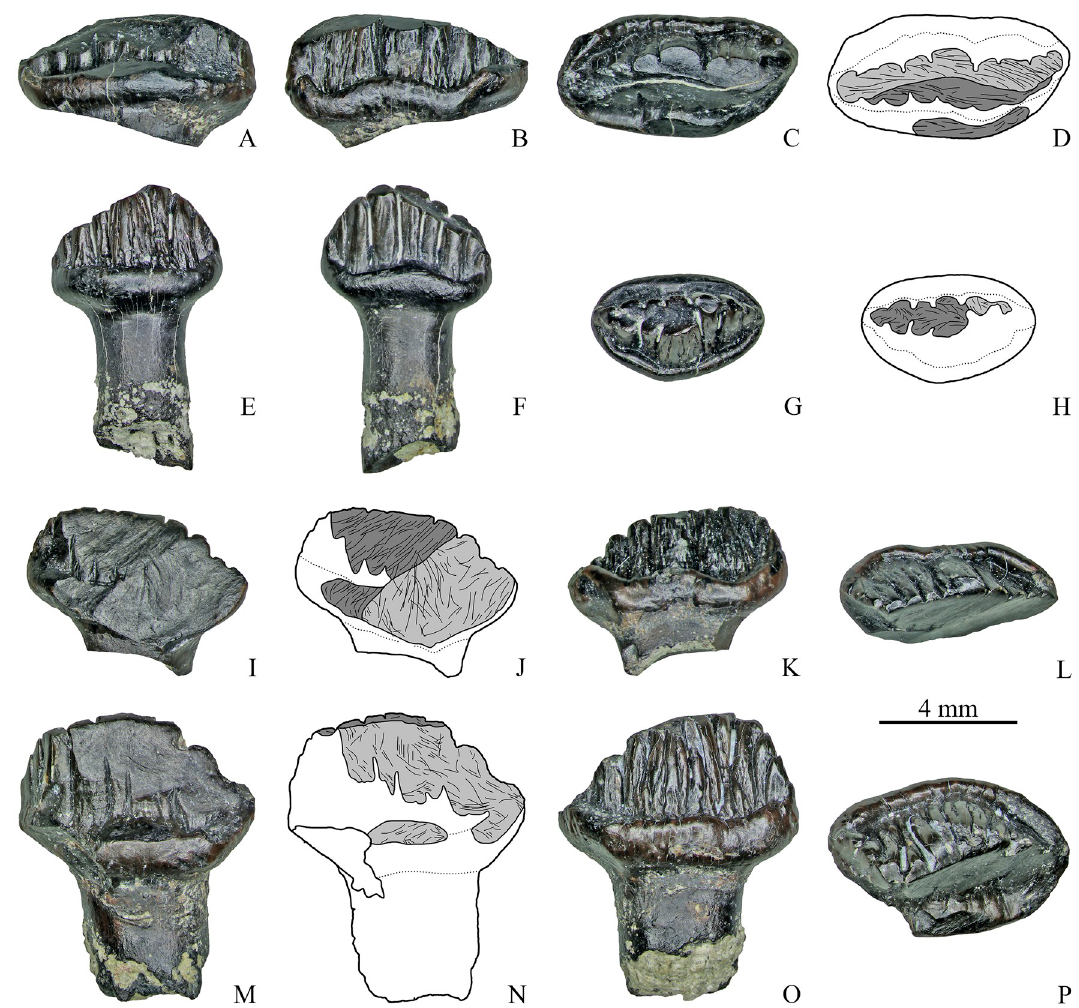
Fig 8. Dentary teeth with two wear facets of Stegosauria indet. from the Teete locality, Yakutia, Russia; Batylykh Formation (Lower Cretaceous). Specimens ZIN PH 16/246 (A-D), ZIN PH 27/246 (E-H), ZIN PH 22/246 (I-L), ZIN PH 50/246 (M-P) in labial (A, E, I, M), lingual? (B, F, K, O), occlusal (C, G, L, P) views, and interpretive drawings in occlusal (D, H) and labial (J, N) views showing the wear facets with